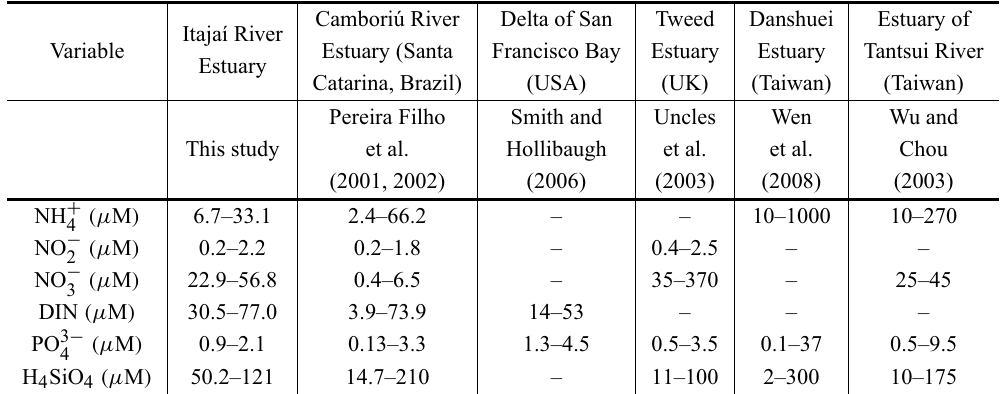
Fig. 8 – Plane formed by axes 1 and 2 of the PCA carried out on the spatial averages, showing the sampling stations (mode Q). The ellipses illustrate the associations found in the cluster analysis. Nutrient concentrations in subtropical estuarine